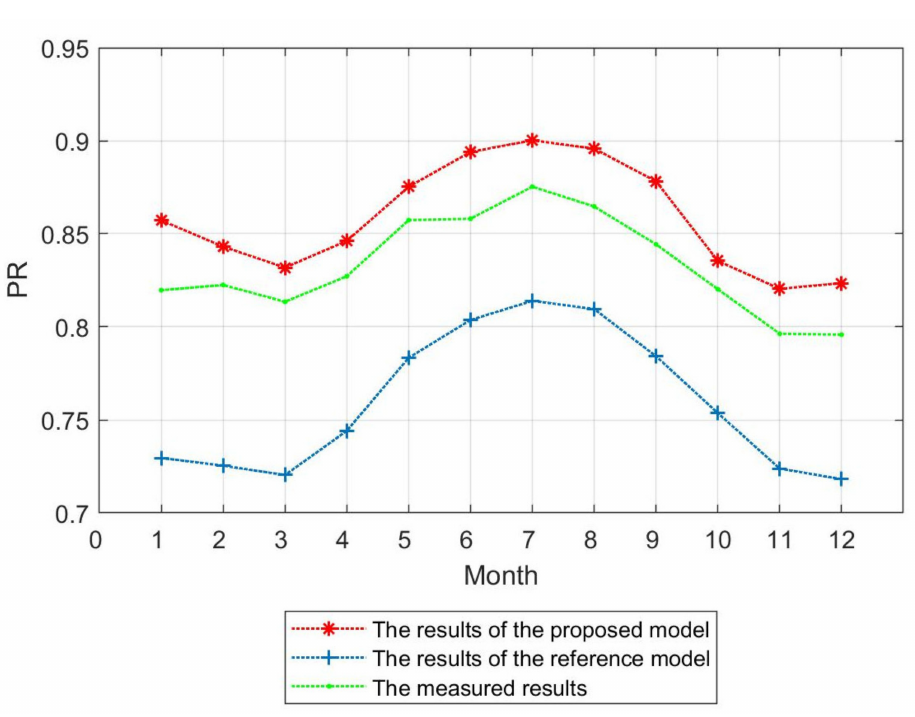
Figure 10. Monthly values of